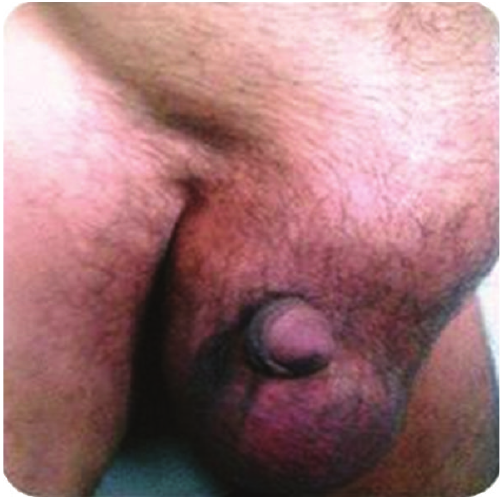
Figure 1: Clinical Photograph of a patient with inguinoscrotal swelling.